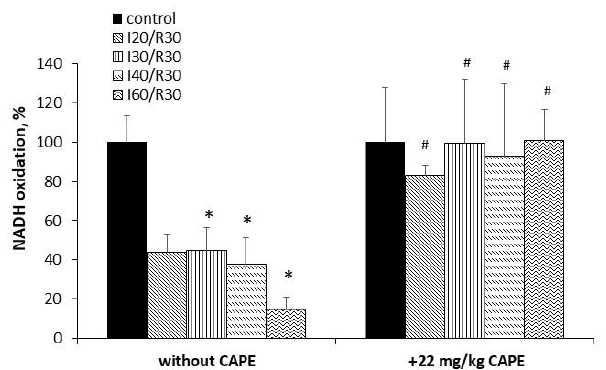
Figure 7. Effect of ischemia/reperfusion and CAPE on Complex I activity in the kidney mitochondria. The Complex I activity was measured spectrophotometrically at 340 nm, as described in the Materials and Methods section. * p < 0.05 vs. the respective control; # p < 0.05 vs. ischemia/reperfusion without CAPE. One-way ANOVA followed by a Fisher LSD post hoc test was used to compare the effects. Ischemia/reperfusion alone diminished Complex II (SDH) activity by 36%, 27%, 57%, and 60% after 20 min, 30 min, 40 min, and 60 min of ischemia/reperfusion, respectively, p < 0.05. CAPE protected the activity of Complex II (SDH) after 20 min and 30 min of ischemia/reperfusion by 32% and 10%, respectively, p < 0.05; however, it was no more effective after longer (40 min and 60 min) periods of ischemia/reperfusion, where the Complex II (SDH) activity had decreased obviously (Figure 8).